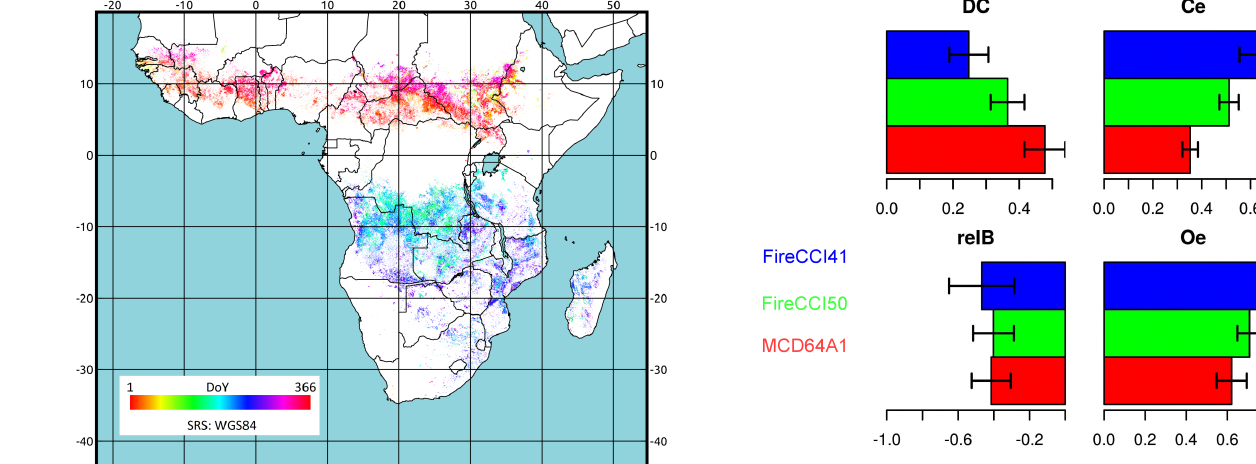
Figure 3. Estimates of Dice coefficient (DC), relative bias (relB), commission error ratio (Ce) and omission error ratio (Oe) at the global scale. Horizontal segments show the 95% confidence inter-